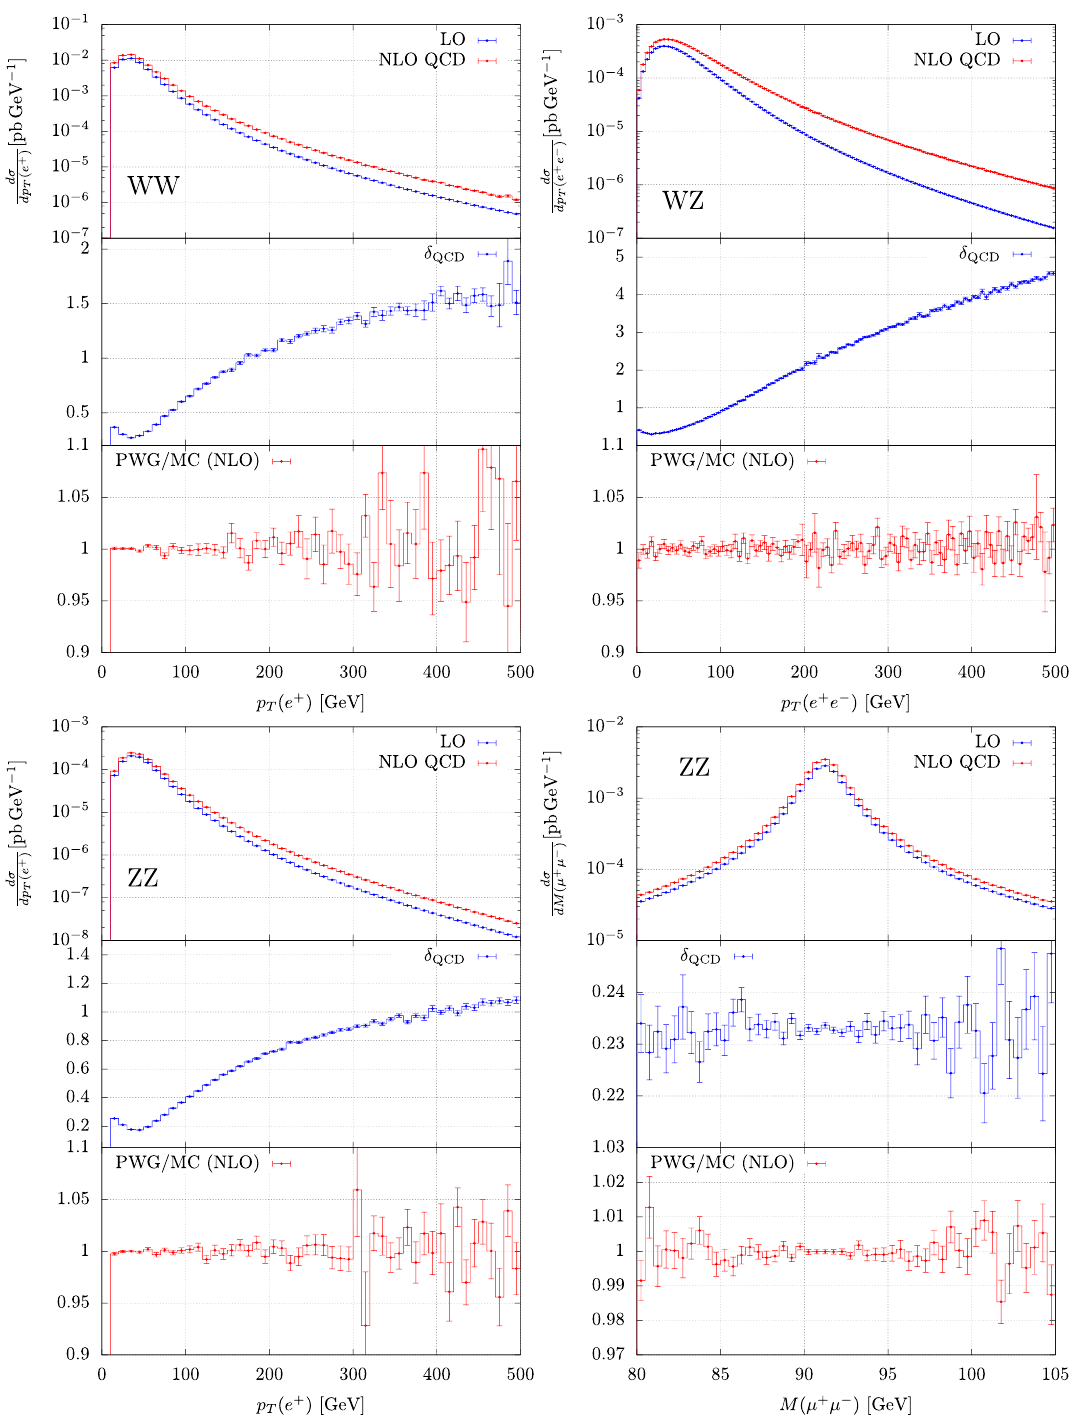
Fig. 2 NLO QCD corrections to pp → e + ν e μ − ν μ (top left), pp → μ + ν μ e − e + (top right), and pp → μ + μ − e − e + (bottom) at the differ- entialdistributionlevel.Factorizationandrenormalizationscalesareset to the four-lepton invariant mass. Top panels: differential distributions